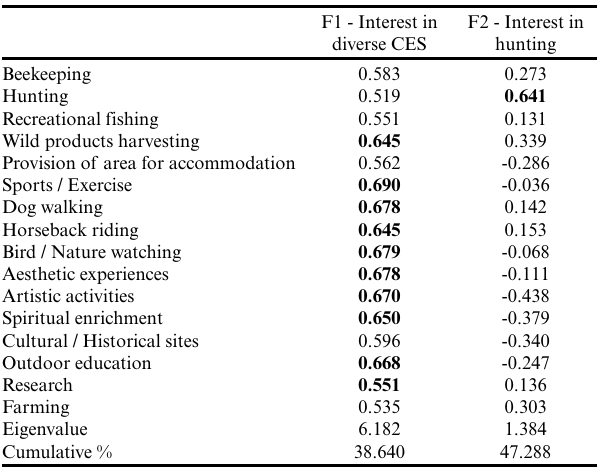
Table 3 . Factor loadings derived from the principal component analysis for potential cultural ecosystem services (CES). For each variable, values in bold correspond to the factor for which the squared cosine is the